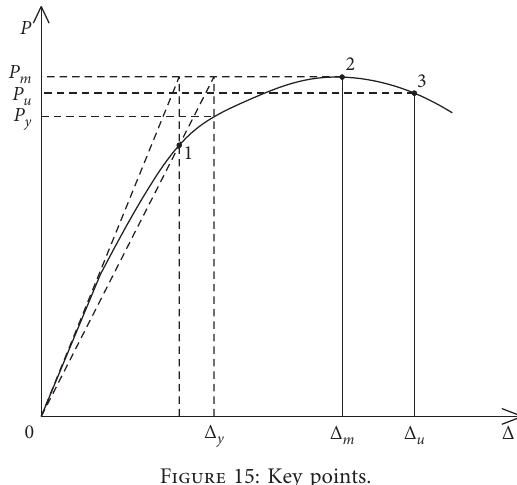
Figure 15: Key points.